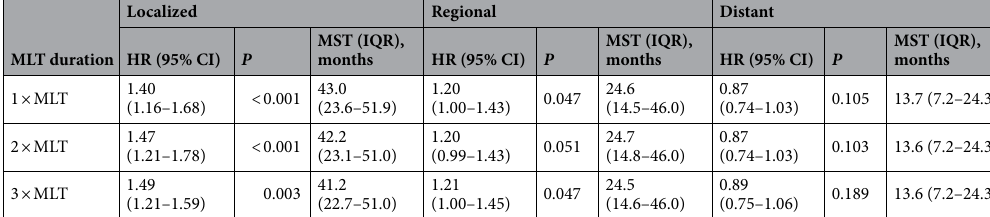
Table 3. Sensitivity analysis of the impact of prior cancer on survival in NSCLC patients for different MLT durations. The estimated MLT durations were set at 3.4, 1.1, and 1.1 months for patients with localized (stage I/II), regional (stage III), and distant (stage IV) NSCLC, respectively. HRs were calculated using Cox proportional hazards models on all-cause mortality in NSCLC patients after subtracting the various MLT durations from survival time in the Prior Cancer Group. CI Confidence interval, HR Hazard ratio, IQR Interquartile range, MLT Mean lead time, MST Median survival time, NSCLC Non-small cell lung